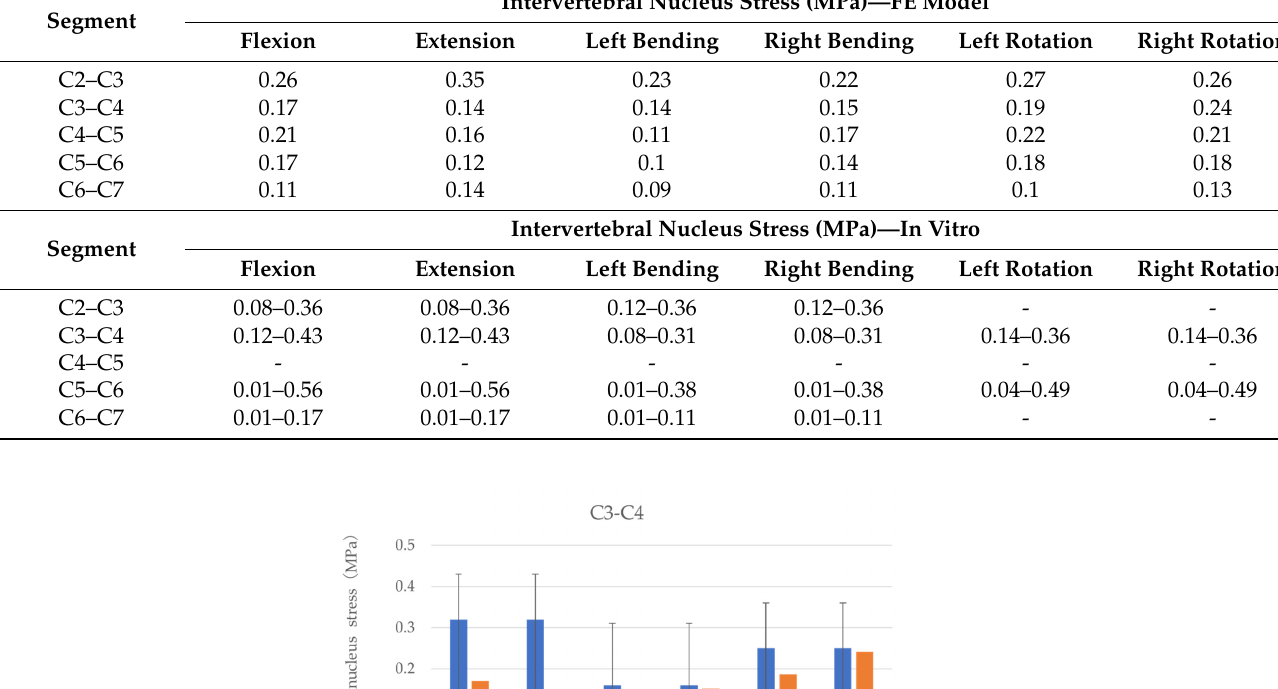
Table 2. Comparison of the intervertebral nucleus stress between the FE model results and the in vitro results reported in the literature [24,26].